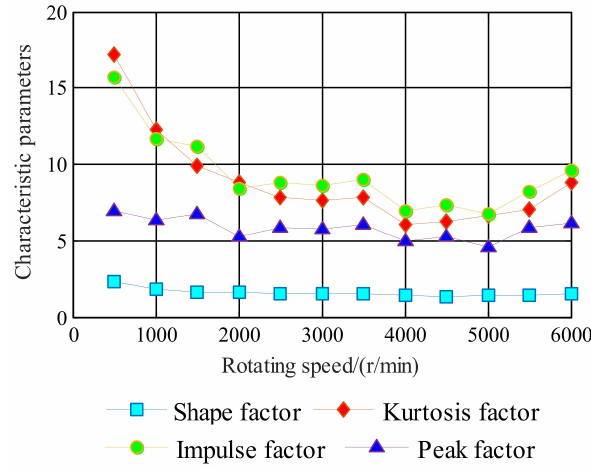
Figure 27. Influence of working speed on dimensionless